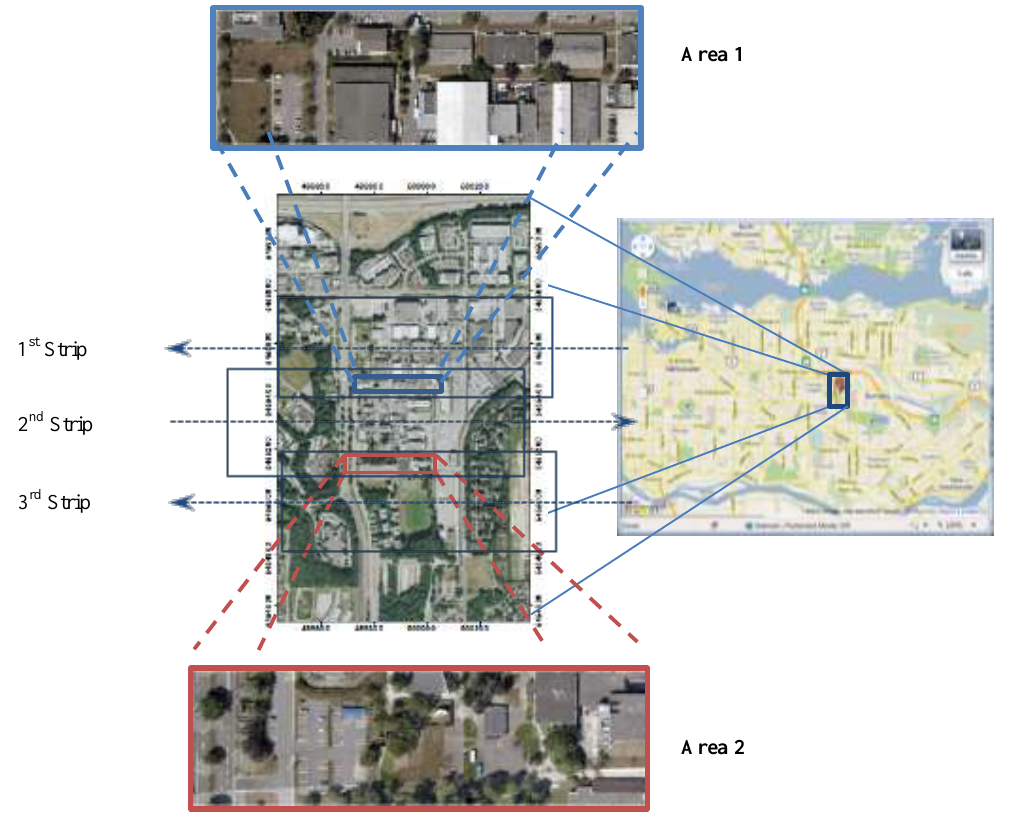
Figure 3: Study areas (clipped from google map and google